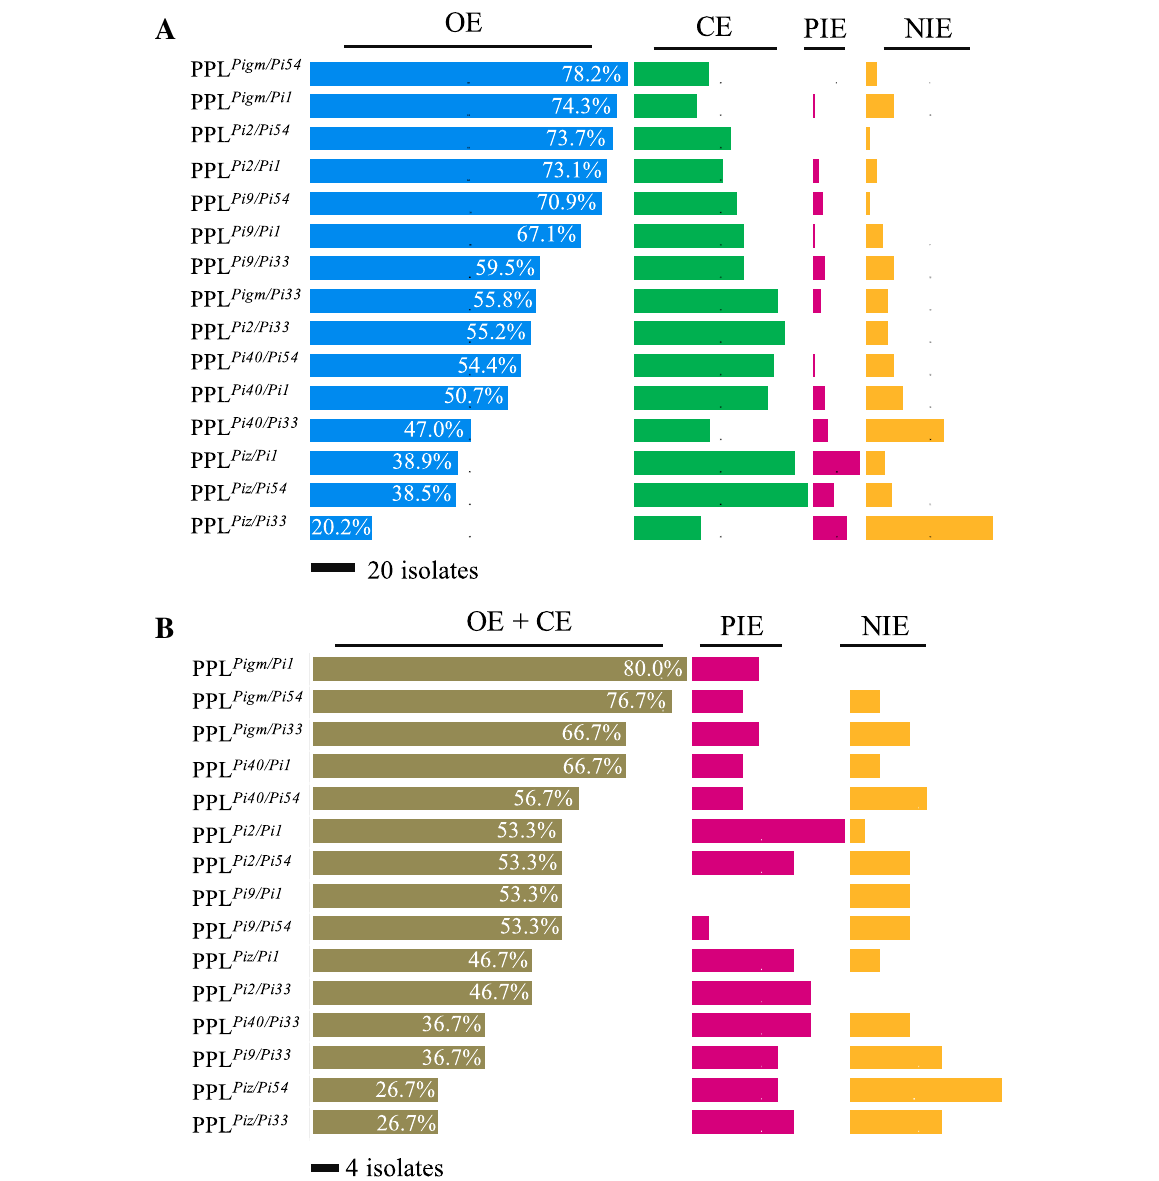
Fig. 4 Four interaction effects affect the seedling and panicle blast resistance level of PPLs. a The interaction effects affect seedling blast resistance level of PPLs, b The interaction effects affect panicle blast resistance level of